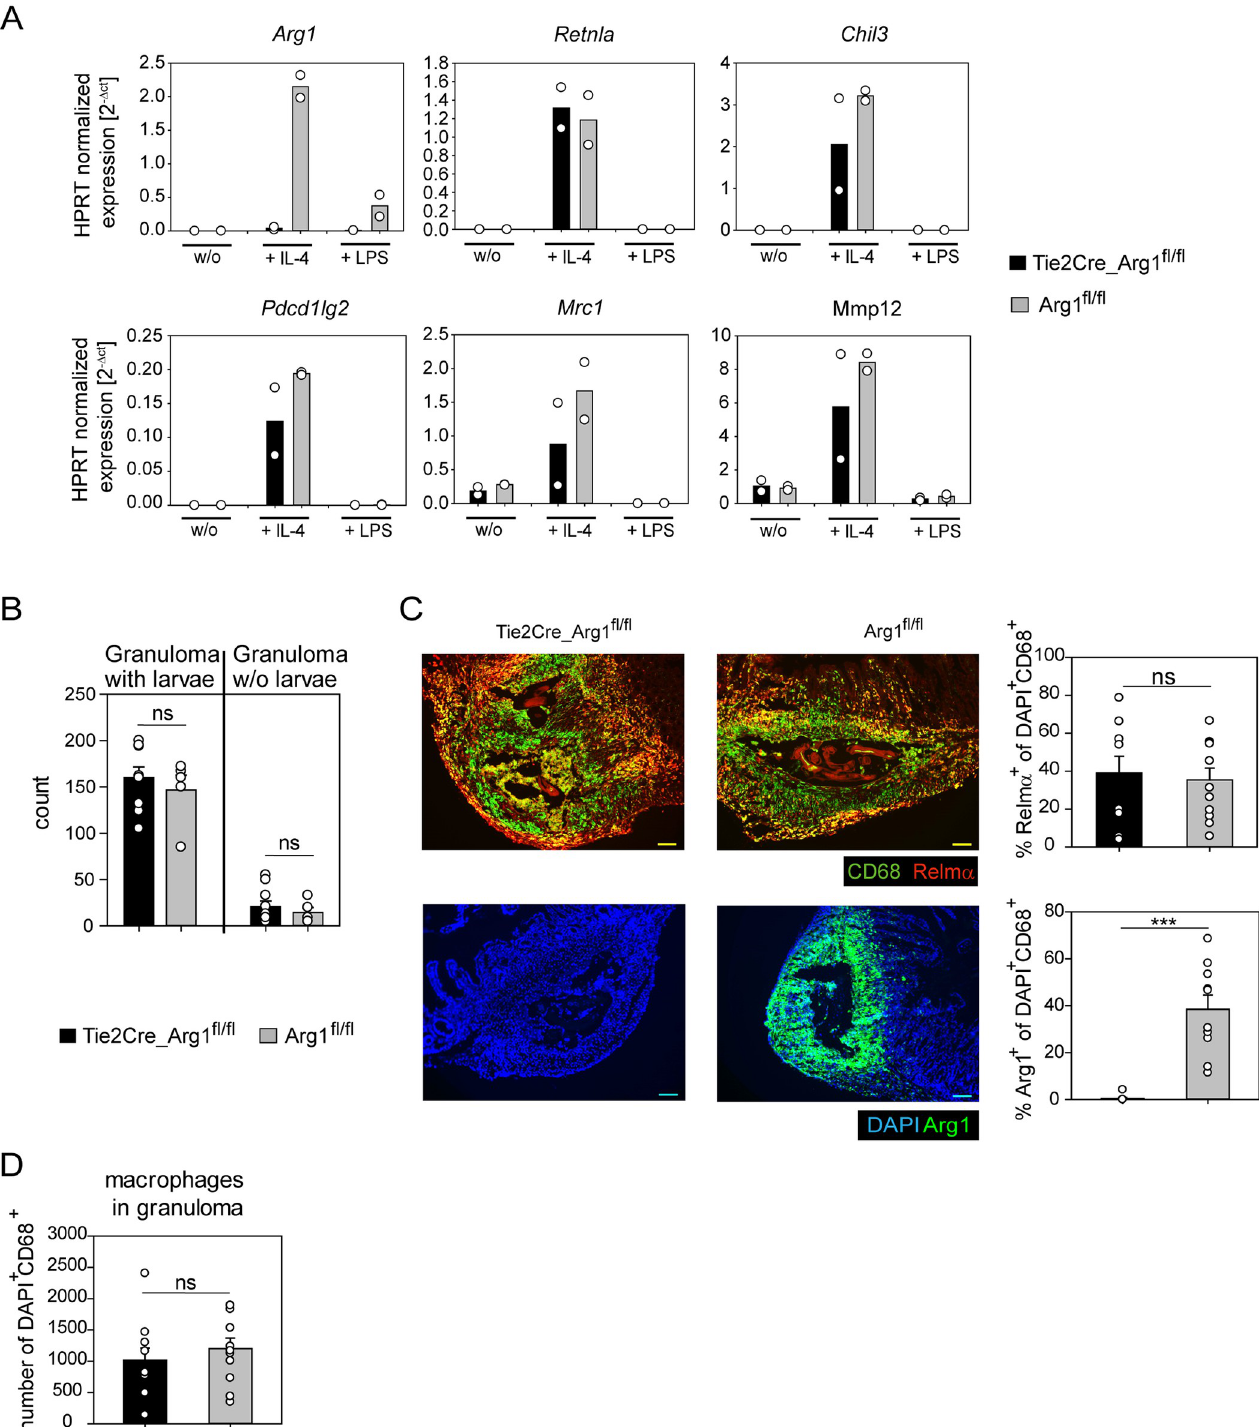
Fig 3. Arg1 is dispensable for larval trapping. A) qRT-PCR of BMDM from mice that lack Arg1 (Tie2Cre_Arg1 fl/fl ) or control mice (Arg1 fl/fl ) stimulated with 20 ng/mL IL-4 or 100 ng/mL LPS for 48 hrs. Bars show mean for two mice per genotype and condition from one experiment. B) Granuloma count on day 9 after secondary Hpb infection in the small intestinal submucosa of Tie2Cre_Arg1 fl/fl and Arg1 fl/fl mice. Mean + SEM number of granuloma with larvae and granuloma without (w/o) larvae of five to ten mice per group pooled from two independent experiments. C) Immunofluorescence staining from small intestinal tissue day 9 after secondary Hpb infection. The upper panel shows staining for Relm- α (red) and CD68 (green) and the lower panel staining for Arg1 (green) and DAPI (blue). Scale bar is 100 μ m. Pictures are representative for ten to eleven mice per genotype from two independent experiments.